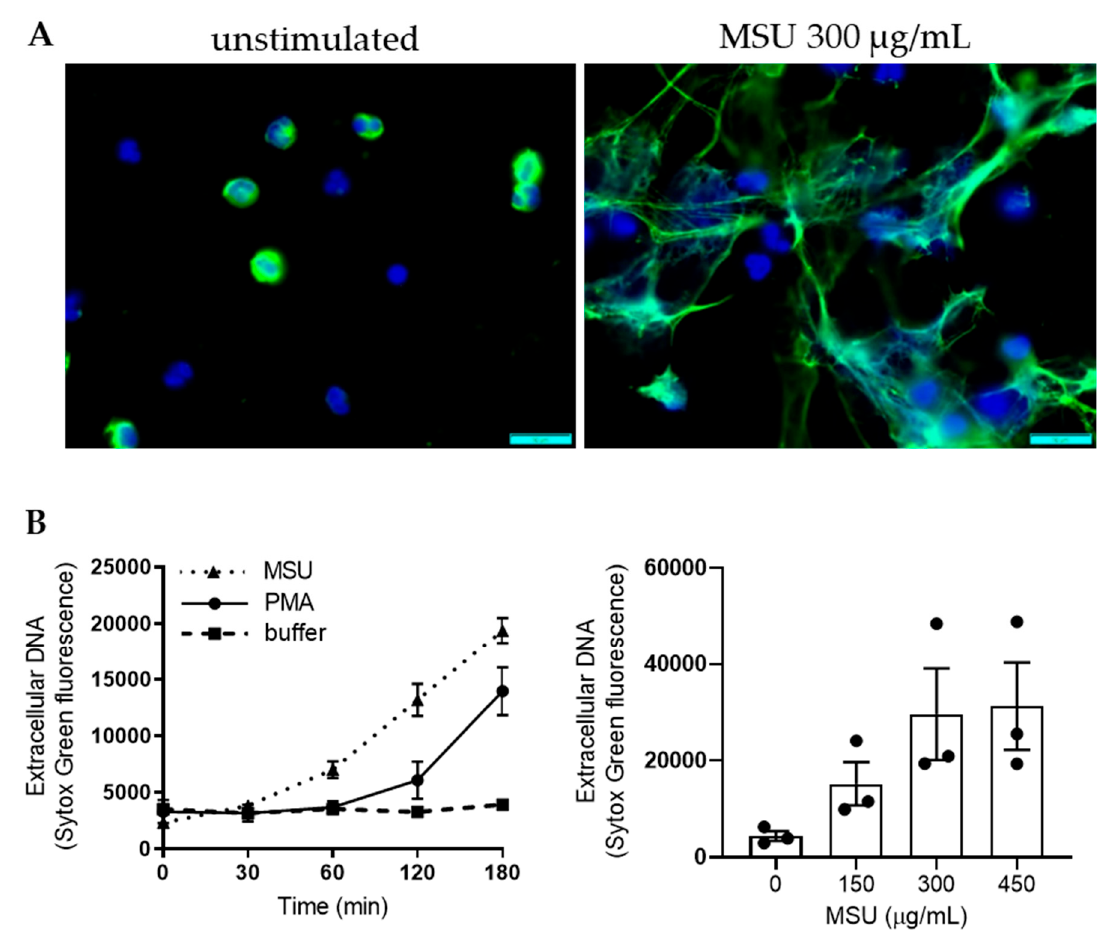
Figure 5. MSU crystals induce neutrophil extracellular trap (NET) formation . ( A ) Neutrophils stimulated with MSU crystals formed NETs as confirmed by DNA- (blue) and MPO- (green) labelled micrographs of neutrophils 3 h after stimulation with MSU crystals (300 µg/mL). Scale bar = 10 µm. ( B ) NET formation as measured with Sytox Green fluorescence over 3 h. To the left, a representative kinetic curve of neutrophils stimulated with buffer (black squares, broken line), MSU crystals (300 µg/mL, triangles, dotted line), or PMA (50 nM, black dots, solid line). MSU crystals (300 µg/mL) triggered a statistically significant DNA release ( p = 0.0005 compared to buffer treated cells after 180 min, n = 12). To the right, NET formation evaluated after 3 h with different concentrations of MSU crystals, mean fluorescence +/- SEM are shown (n = 3). Statistical significance was calculated by the use of the Wilcoxon matched-pairs signed rank test.